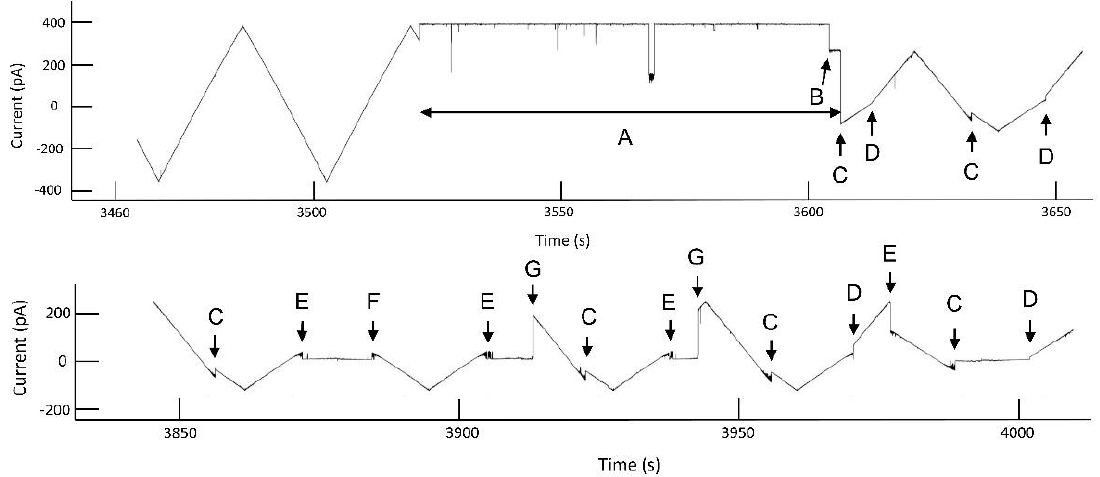
Figure 2. Voltage gating in a single Triplin. On the left side of the upper trace, a triangular voltage wave (+88/ − 87 mV; 30 mHz) results in no channel gating. In region “A”, a +90 mV potential was applied to the cis compartment. At point “B”, channel 1 closed. The resumption of the triangular wave causes gating of channels 2 and 3. “C” indicates the location of channel 2 closures and “D” the locations of channel 2 reopening. “E” and “F” are the locations of channel 3 closure and reopening, resp. “G” indicates double reopenings of channels 2 and 3. At 3977 s there is an unusual closure of channel 3 (a forbidden transition) when channel 2 is still open. The region between times 3977 s and the end of the record is an unusual period during which only channel 2 is open and